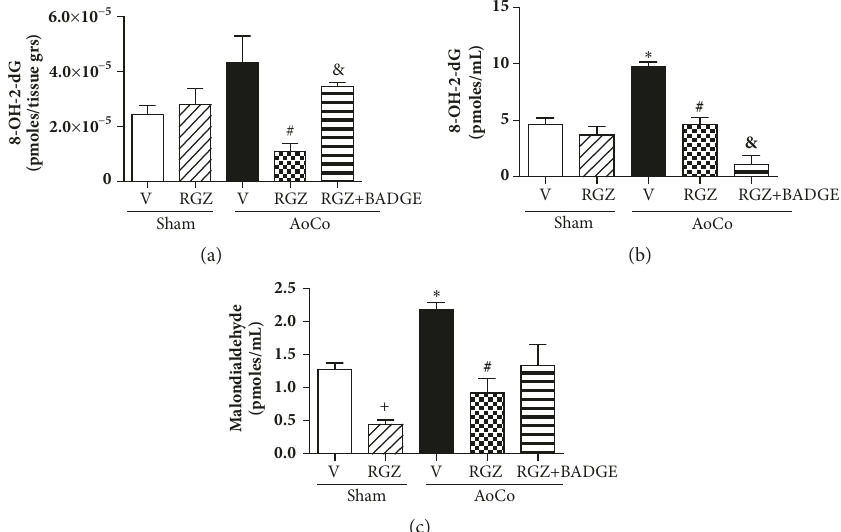
Figure 6: Effect of rosiglitazone (RGZ) on 8-hydroxy-2 󸀠 -deoxyguanosine (8-OH-2-dG), a marker of oxidative stress-induced DNA damage in homogenatefrom aorta (a) and serum(b), and serum malondialdehyde (c) from sham or aorticcoarctated(AoCo) rats treated with vehicle (V), rosiglitazone (5mg/kg, RGZ), or RGZ + bisphenol A diglycidyl ether (120 mg/kg, RGZ+BADGE). The values represent the mean ± SEM (n=6 animals of group). One-wayanalysis of variance(ANOVA)post Tukey. ∗ P < 0.05 Sham-Vvs. AoCo-V, # P < 0.05 AoCo-Vvs. AoCo-RGZ, and & P < 0.05 AoCo-RGZ vs.